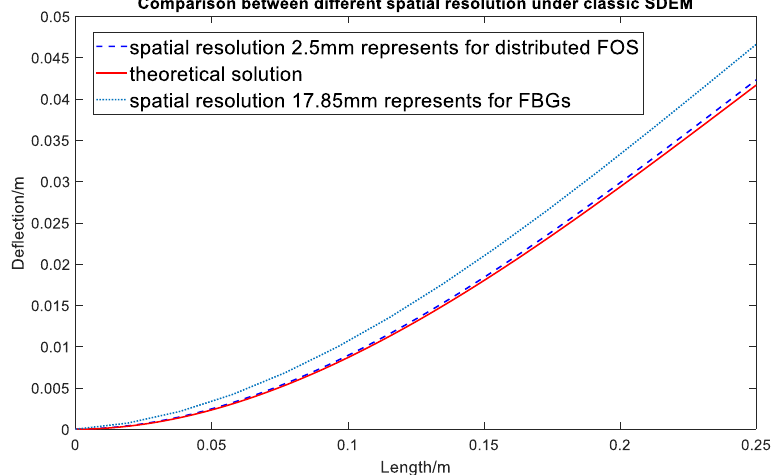
Figure 11. Comparison between different spatial resolutions in SDEM.